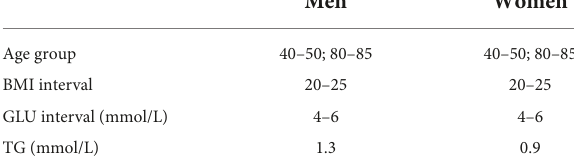
TABLE 5 Transition points for age, BMI, GLU, and TG in terms of the risk of high DBP. Men Women